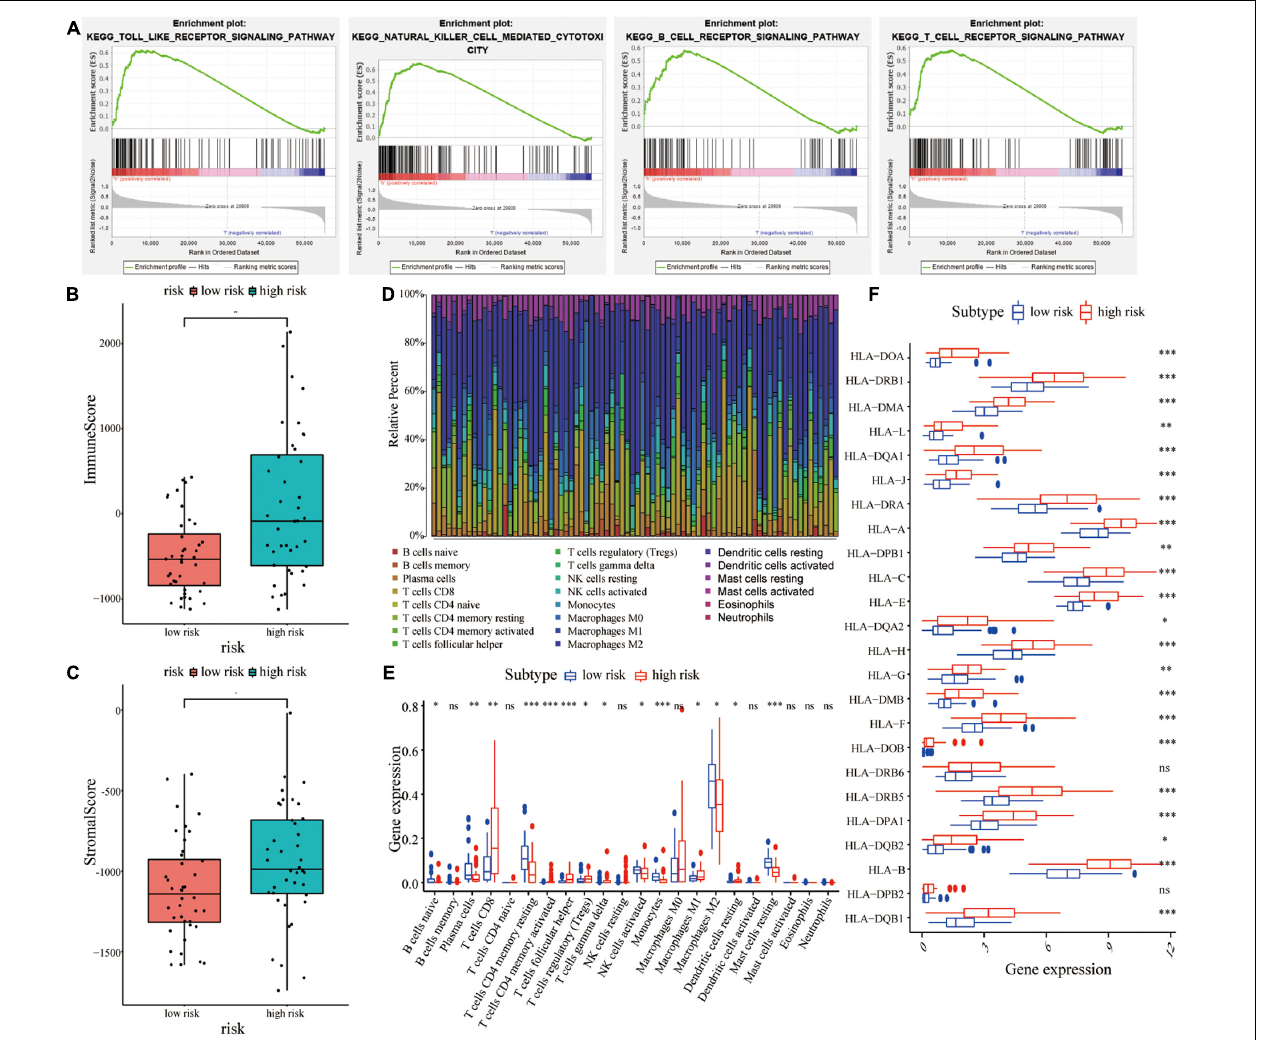
FIGURE 8 | Correlations between lncRNA signature and immune cell infiltration in UM patients. (A) GSEA showed that various immune-related signaling pathways were enriched in the high-risk group compared with the low-risk group. (B,C) Comparisons of immune score and stromal score between the high-risk and low-risk groups. (D) Histogram of the 22 different specific immune cell infiltration in each UM samples. (E) Comparisons of various cell types in immune infiltration between the high-risk and the low-risk groups. (F) Comparisons of various HLA family genes between the high-risk and low-risk groups. * P < 0.05, ** P < 0.01, *** P < 0.001.